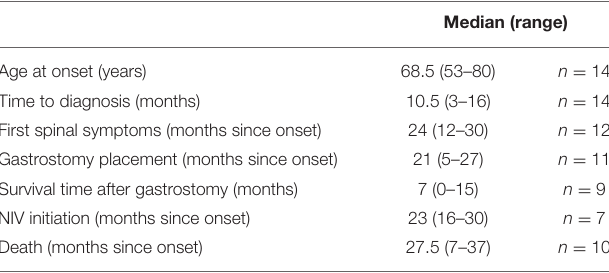
TABLE 1B | Demographic data and timeframe of interventions of patient cohort with progressive bulbar